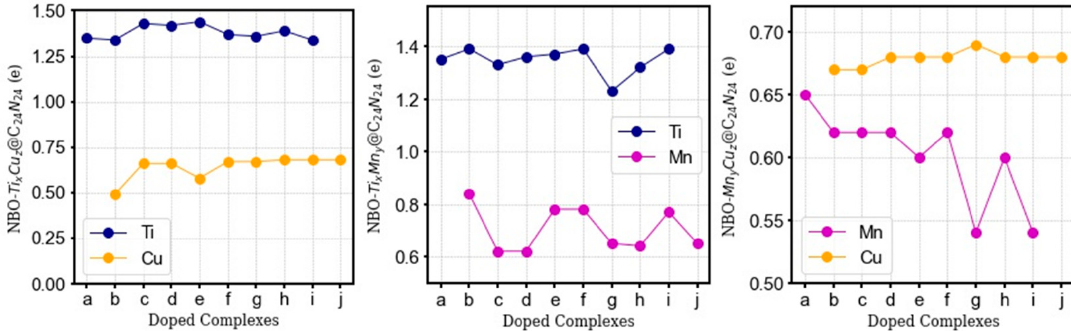
Figure 4. NBO charge analysis of individual Ti, Mn, and Cu atoms in Ti x Cu z @C 24 N 24 , Ti x Mn y @ C 24 N 24 , and Mn y Cu z @ C 24 N 24 . The a–j complexes refer to the metal distribution patterns presented in Figure 2. All values are in eV.